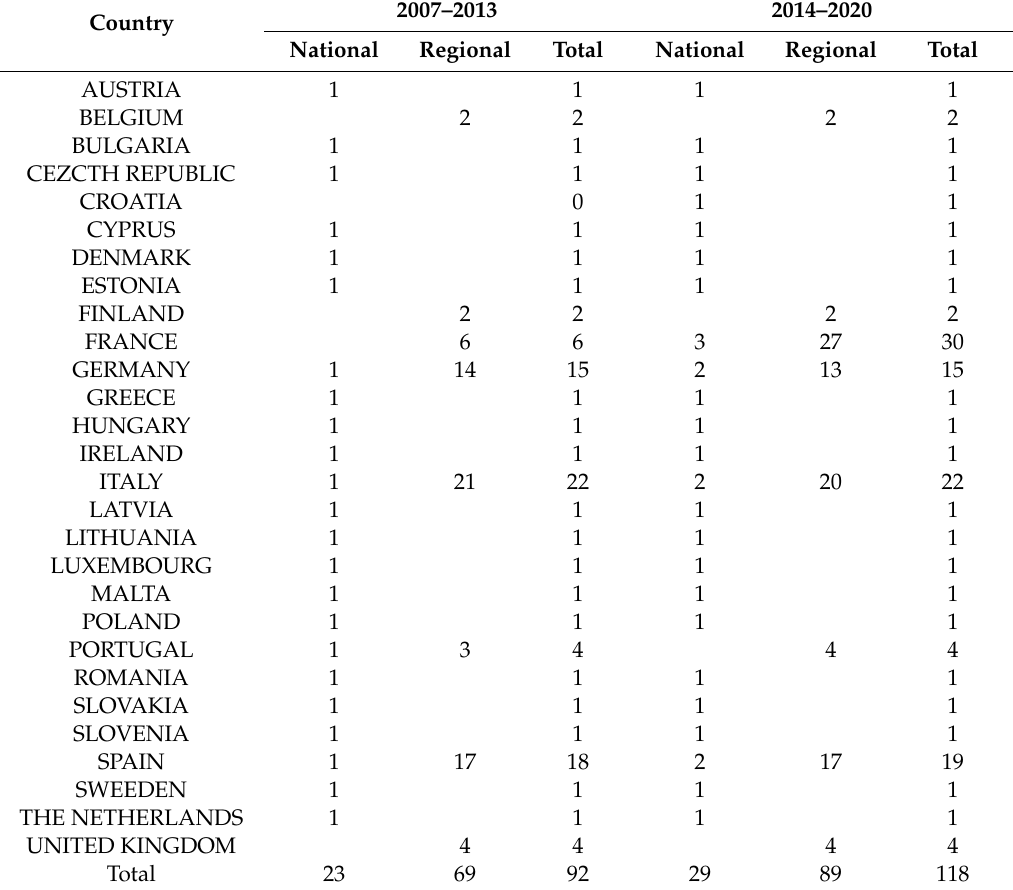
Table A4. Rural development programmes